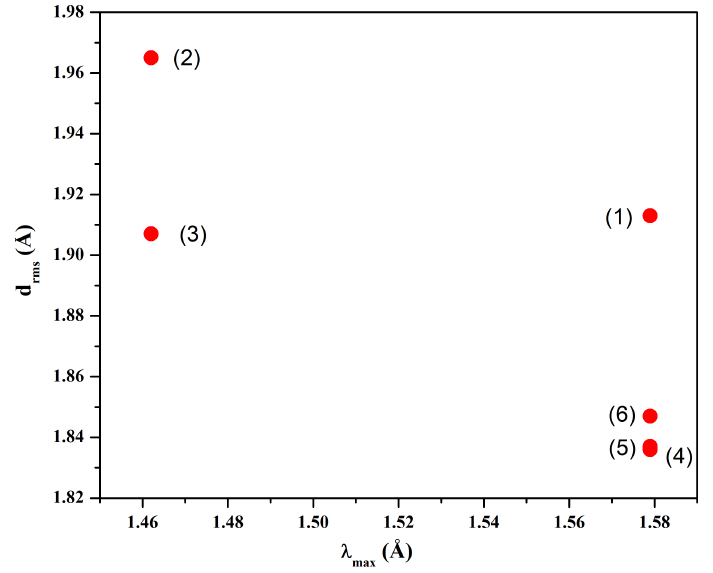
Figure 12. The correlation between the effective molecular diameter, d rms , and the incident electron wavelength, λ max , at a maximum of ionization cross section for vinyl ether and its isomers. (1): vinyl ether; (2): 2-butenal; (3): cis-2-butenal; (4): cyclobutanone; (5): furan, 2, 3-dihydro; (6): furan, 2, 5-dihydro.